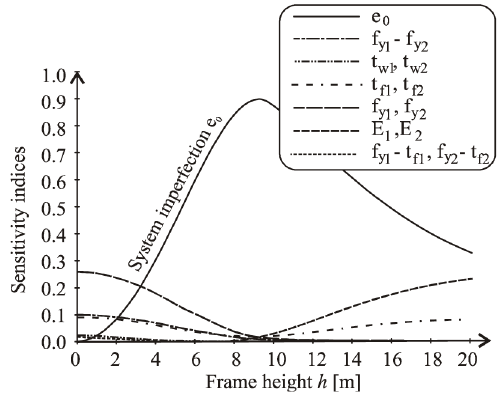
Fig. 10. Sensitivity analysis – Frame 1